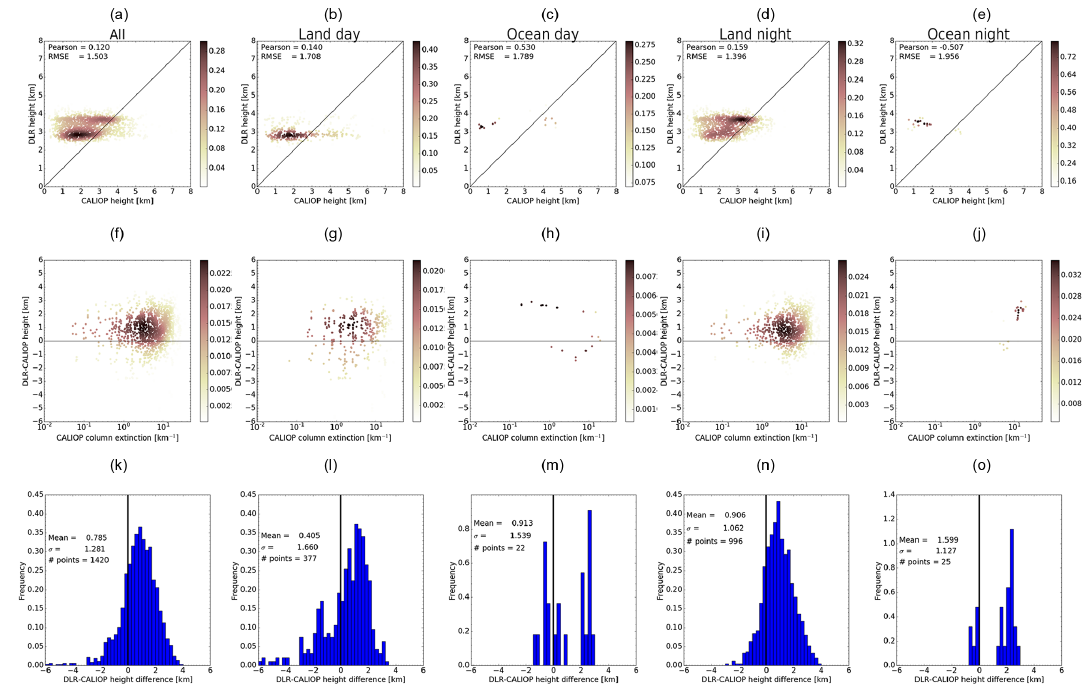
Figure A6. Similar to Fig. A5 but for the DLR